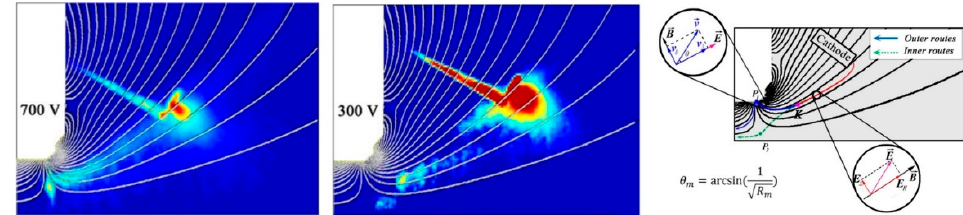
Figure 12. Experimental results of the two conduction routes in the cusped field thruster.